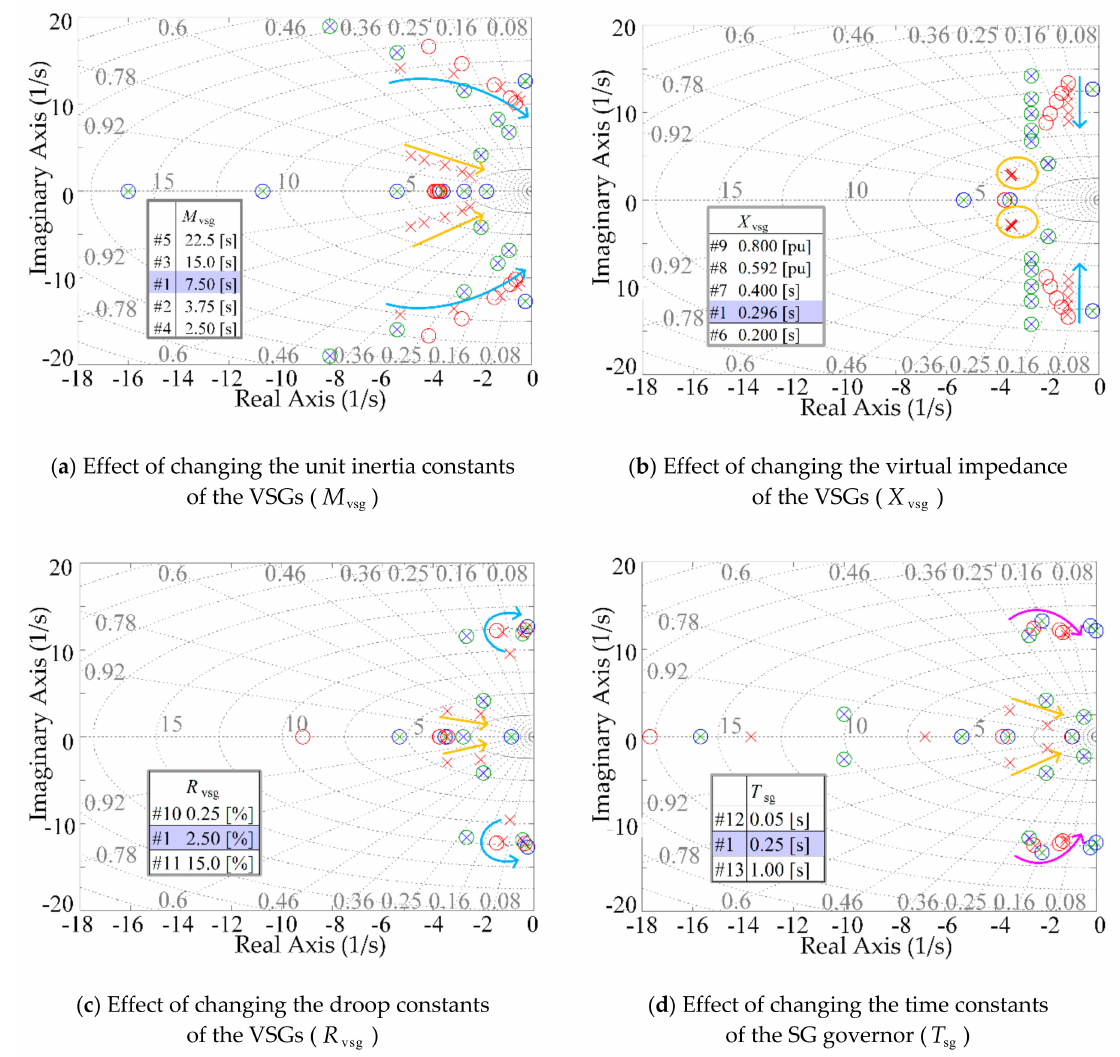
Figure 13. Poles and zeros of the transfer functions: the light blue, yellow and pink arrows/circles indicate that the parameters are increasing; red represents the deviation of the center of inertial frequency ( G c ( s ) ); blue denotes the frequency (cid:95) G vsg ( s ) ); and green denotes the frequency deviation ratio of the VSG to the SG ( deviation ratio of the SG to the VSG (